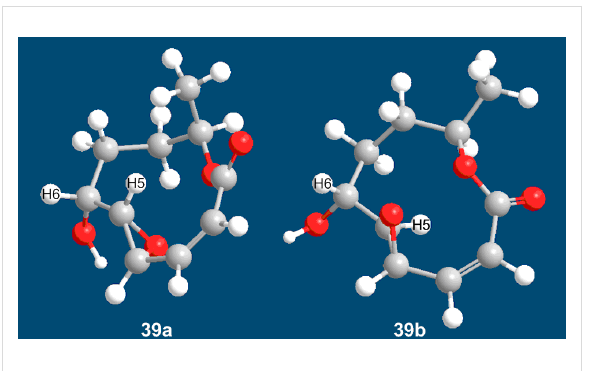
Figure 2: MM2 energy-minimized structures of 39a and 39b